Question: Condense the content of this figure into a single sentence.
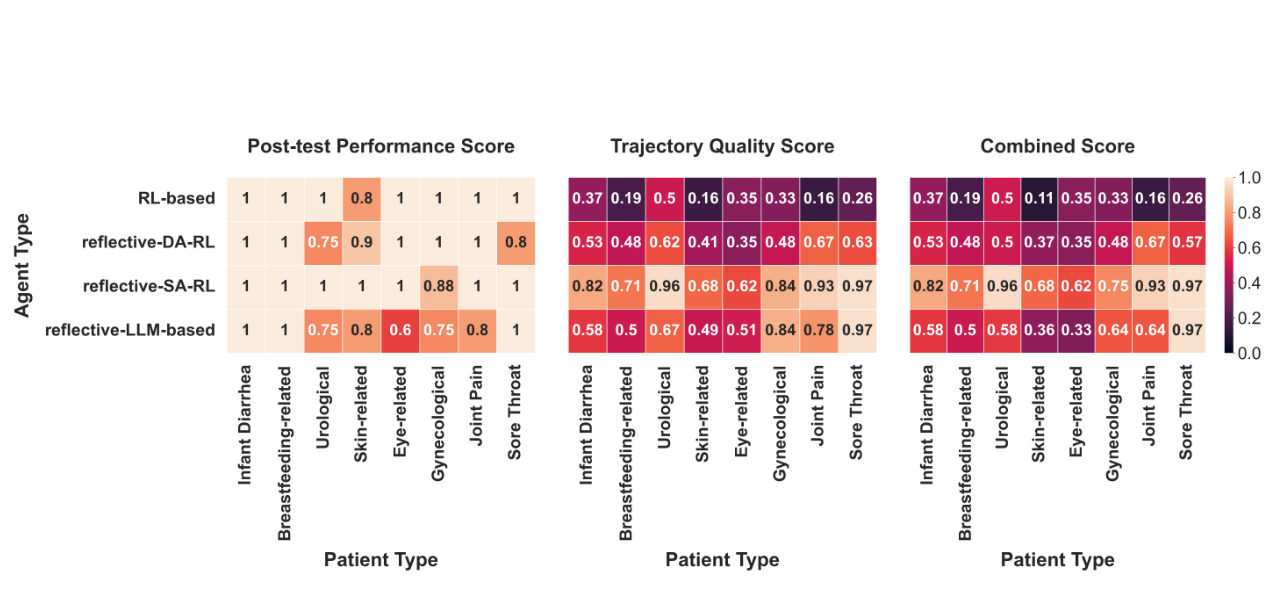
Answer: Performance of different agents in interaction with different patients. Post-test Performance Score (left), Trajectory Quality Score (middle), and Combined Score (right) for RL-based and reflective SA-RL, DA-RL, and LLM-based agents.